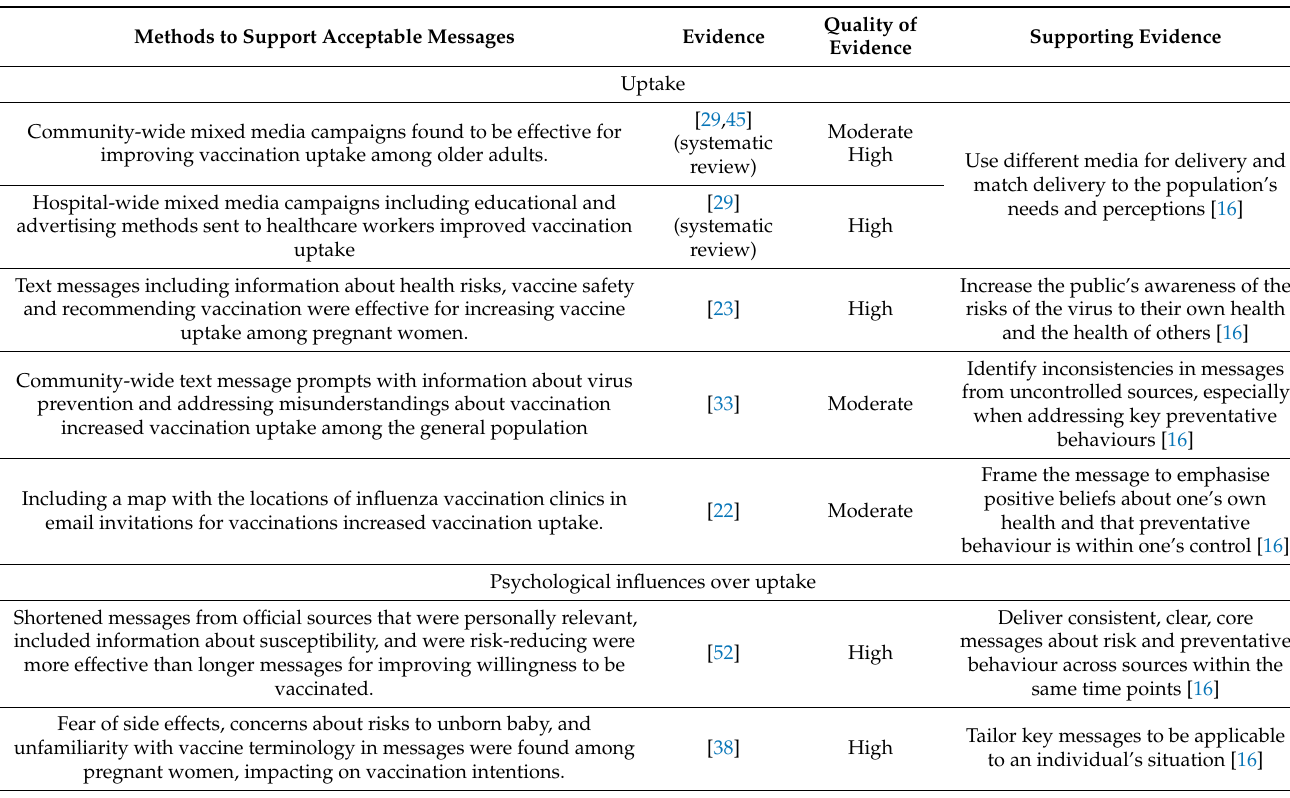
Table 2. Summary of moderate to high quality evidence of methods to support vaccination uptake, beliefs and intentions with supporting evidence from a broader review of public health messaging